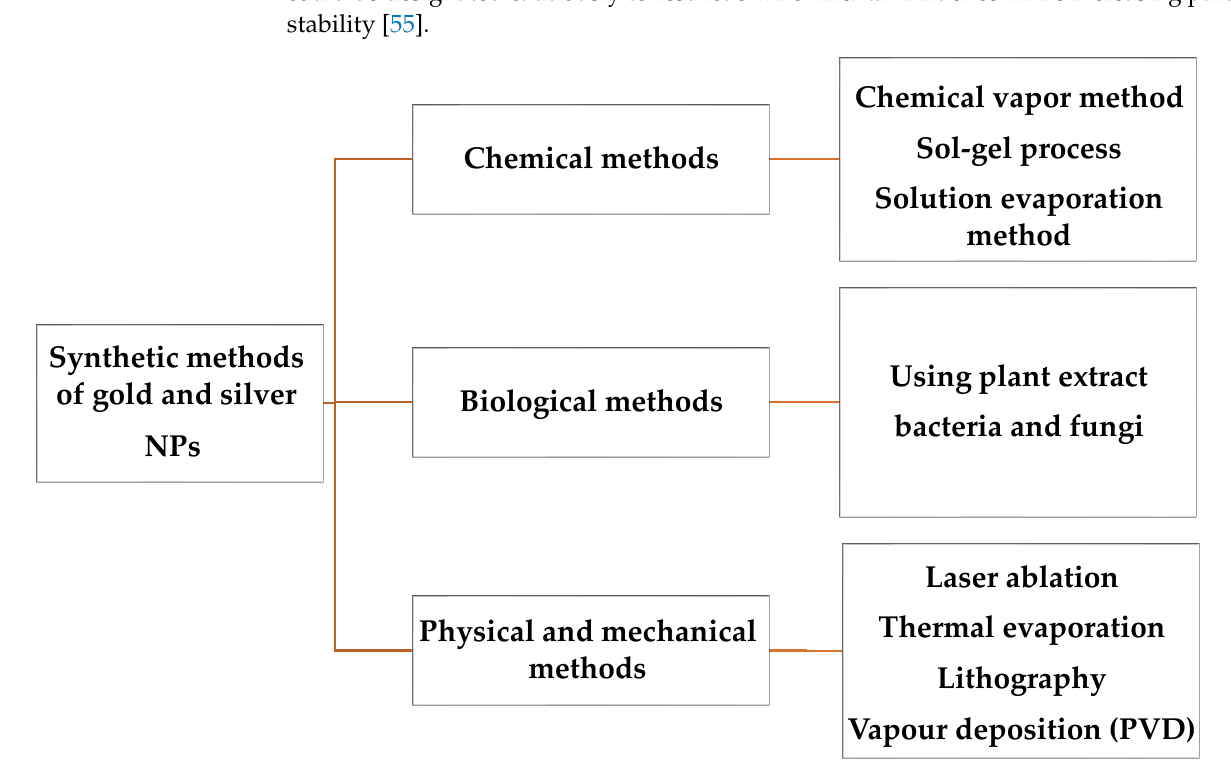
Figure 1. Various synthesis methods of Ag and Au NPs.